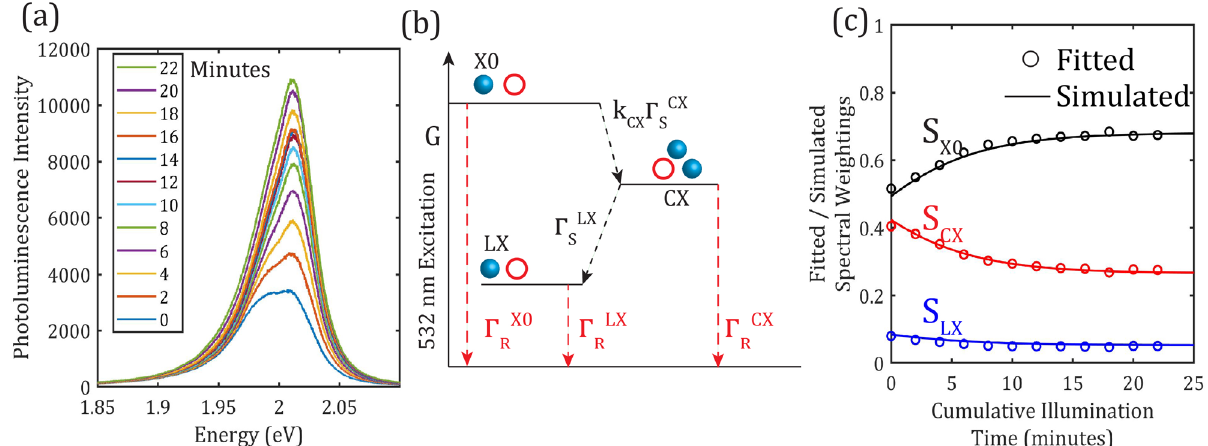
Figure 2. ( a ) PL spectrum series measured over 22 min laser illumination showing the evolution of the PL spectrum over time I L = 6 kWcm − 2 , t i = 1 s . ( b ) Diagram illustrating model used to describe dynamics of excited state populations, corresponding with Eqs. (1–5) ( c ) Fitted spectra weightings of exciton (X0), charged exciton (CX), and localised exciton (LX) emission (plotted as circles) compared with simulated data (plotted with lines) obtained using the proposed model. Error bars are estimated to be smaller than the data points, more on this can be found in the supplementary